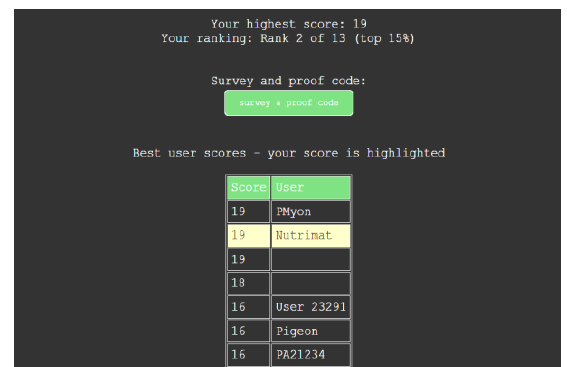
Figure 8 . High score list with worker IDs.